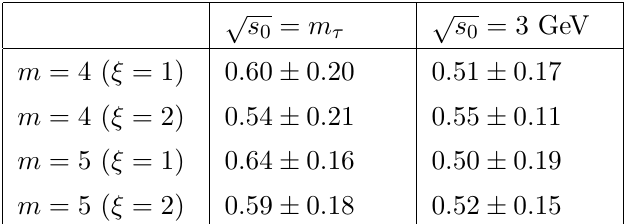
, (3 GeV ) , and ξ = 1 , 2 . The uncertainties at order m = 4 τ √ √ s 0 ≤ R ≤ s 0 and at order m = 5